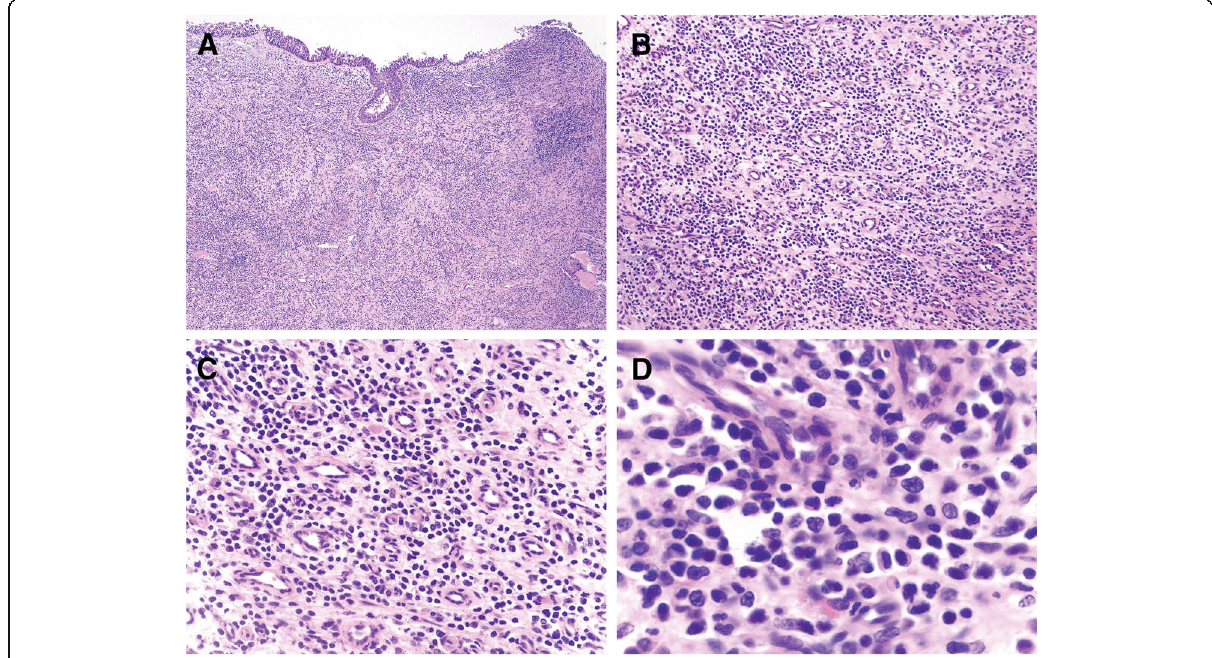
Fig. 1 Histological findings of the nasal biopsy. a H&E-stained sections at low magnification (50x) demonstrate a diffuse infiltrate in the submucosa (H&E). At higher magnification b 200x and c 400x), the majority of the cells are small to medium-sized and have irregular nuclei and inconspicuous nucleoli. d High magnification (1000x) highlights the irregular nuclear contours